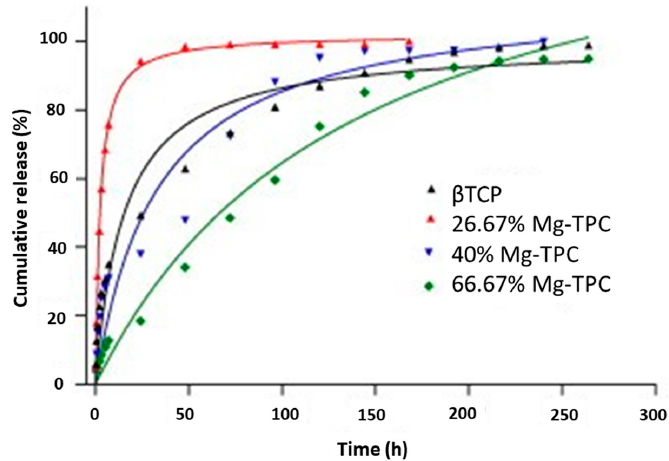
Figure 5. Release of vancomycin from different CPCs. Reprinted from [85] with permission from Elsevier.